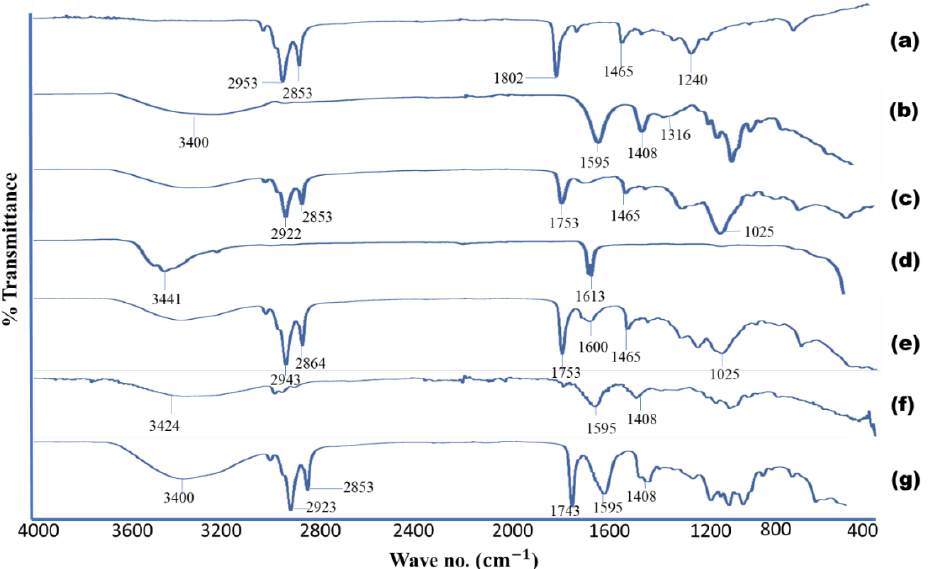
Figure 5. Showing the ATR-FTIR spectra of ( a ) BSO, ( b ) sodium alginate, ( c ) lecithin, ( d ) calcium chloride, ( e ) BSO-free beads, ( f ) alginate-BSO beads, ( g ) physical mixture of all ingredients.